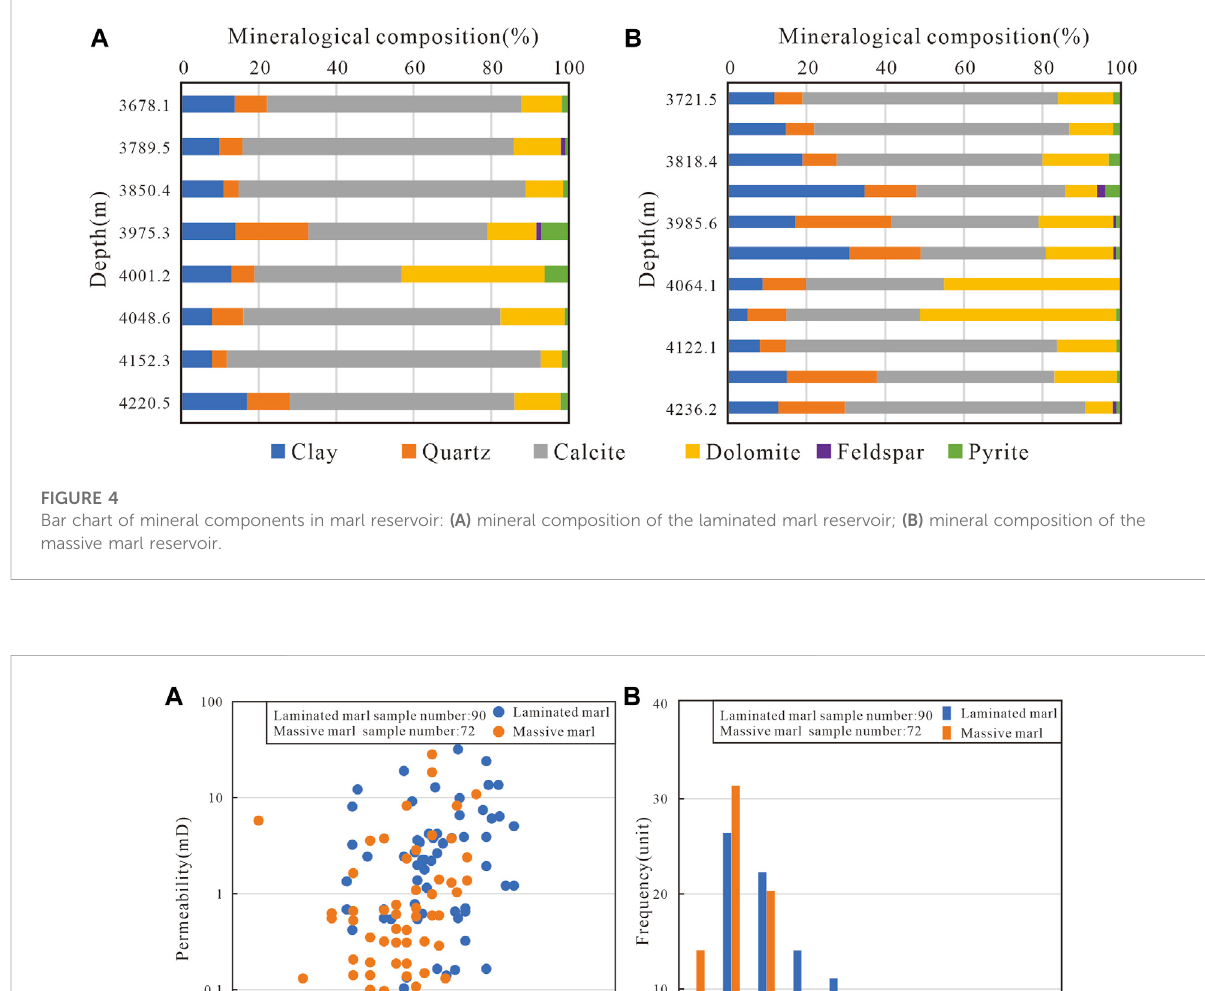
Frontiers in Earth